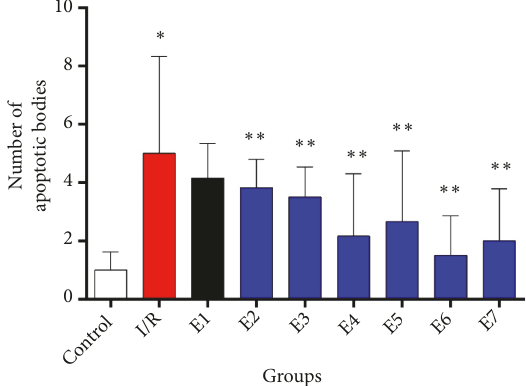
Figure 4: Effect of different doses of FK506 on the number of apoptotic cells in the hippocampal dentate gyrus area. Results revealed a significant difference between control and I/R group. Although there was no significant difference between I/R and E1 group, FK506 treatment could cause considerable reduction of apoptotic bodies in E2-E7 groups. Data are presented as mean ± SD. ∗ P ≤ 0.05 vs. control group, ∗∗ P ≤ 0.05 vs. I/R